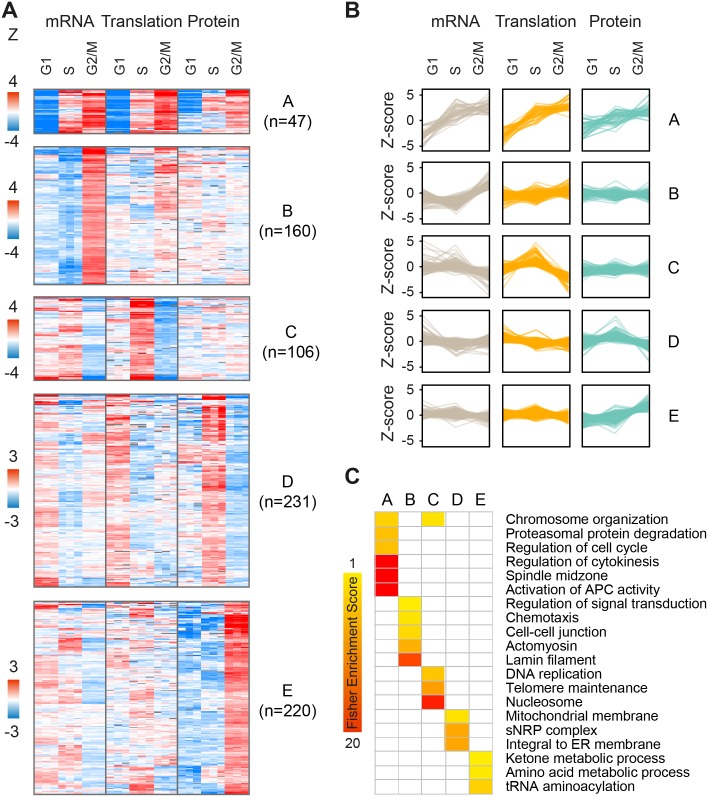
Clustering of periodic gene products.(A-B) K-means clustering of gene products showing statistically-significant (one-sample T-test of fold-changes, FDR<0.05) changes along the cell cycle in at least one of mRNA, translation and/or protein levels. Each panel represents a distinct cluster with a separate heatmap (A) and profile plot (B) reporting Z-transformed values for fold-change mRNA, translation and protein levels. G1, S and G2/M represent fold-change ratios relative to the previous cell cycle phase i.e. G2/M-to-G1, G1-to-S, and S-to-G2/M, respectively. (C) Fisher enrichment scores for the clusters A-E (FDR <0.02, selected categories). The complete enrichment analysis is included in S5 Table.